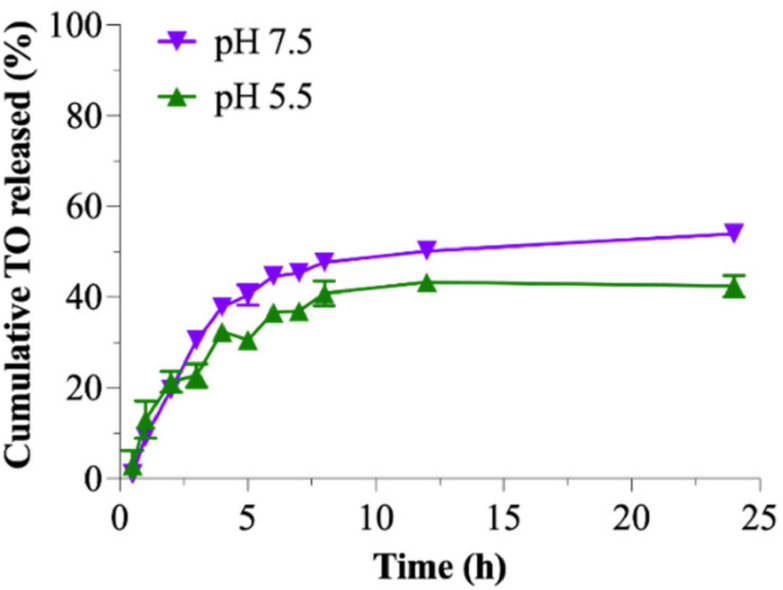
Figure 5. Cumulative release of TO from the TO-FA-CS-Alg-NCs in pH 5.5 and